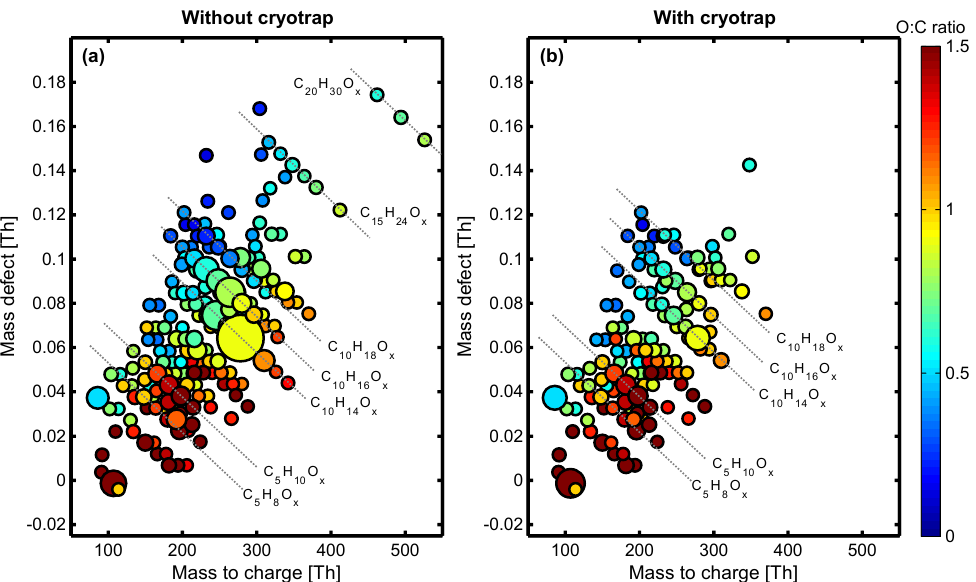
( HNO 3 ) 0 − 2 ) for (a) isoprene 3